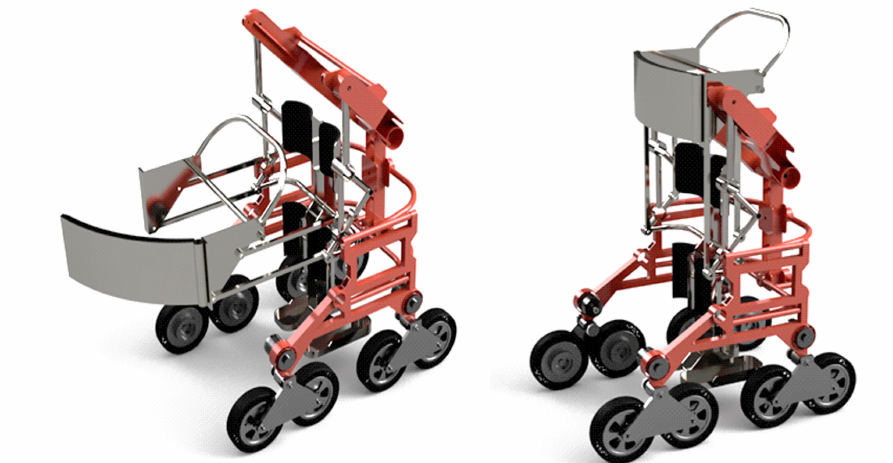
Figure 4. Seated-standing Mechanism. ( Left ) Seated Position, ( Right ) Standing